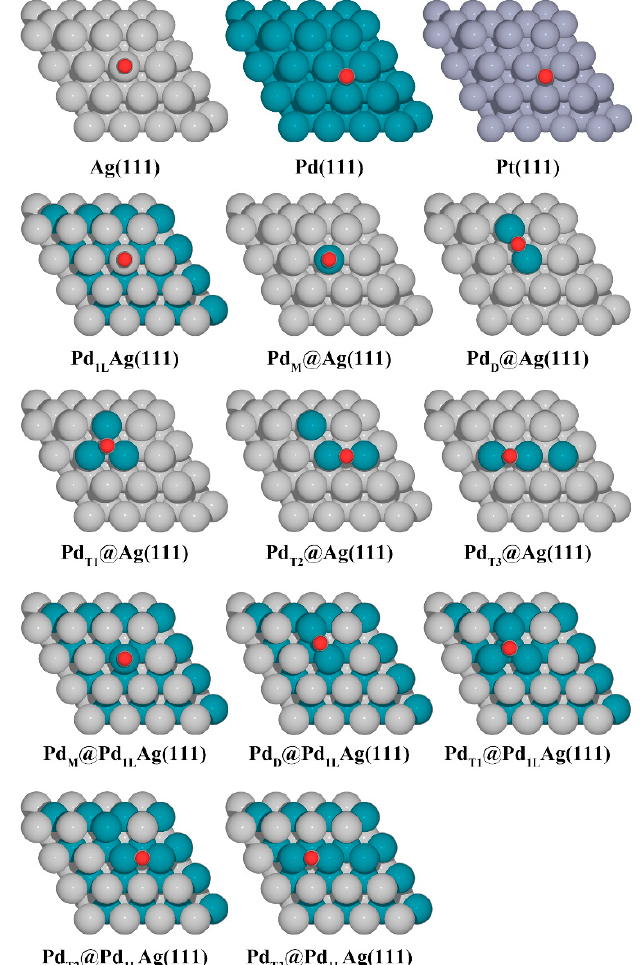
Figure 7. Top view of the most stable structures of CO on all slab models. The silver, cyan, gray, brown, and red balls represent Ag, Pd, Pt, C, and O atoms, respectively.